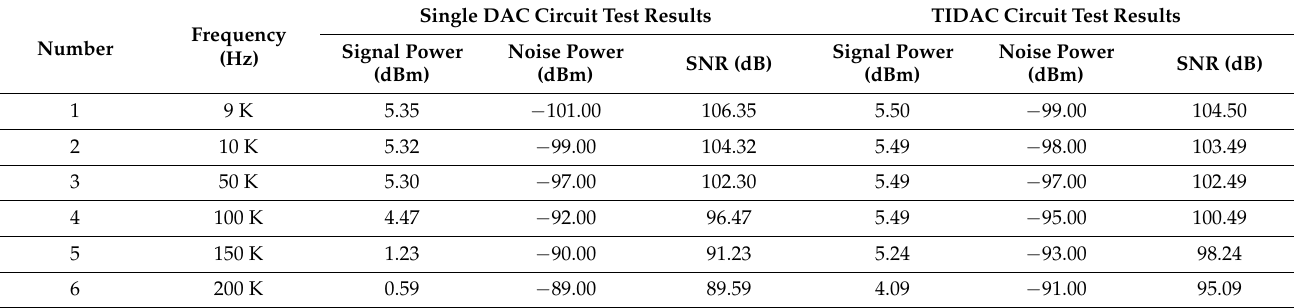
Table 1. SNR test